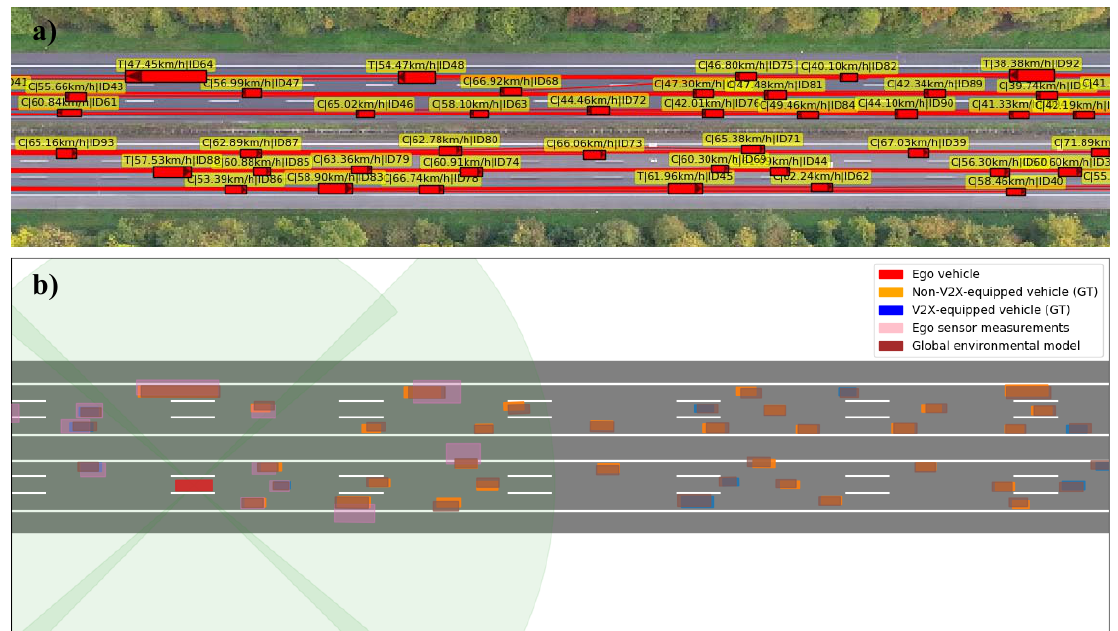
Figure 6. High-density highway segment of scenario B: ( a ) Ground truth positions of the vehicles as contained in the highD dataset; ( b ) Visualization of the environmental perception of a vehicle (red box), showing the sensor measurements (pink boxes) and the fused global environment model (brown boxes) for a V2X market penetration of 25%. They are superposed over the ground truth states’ bounding boxes of the surrounding traffic, differentiating between V2X-equipped (blue boxes) and non-V2X-equipped vehicles (orange boxes).